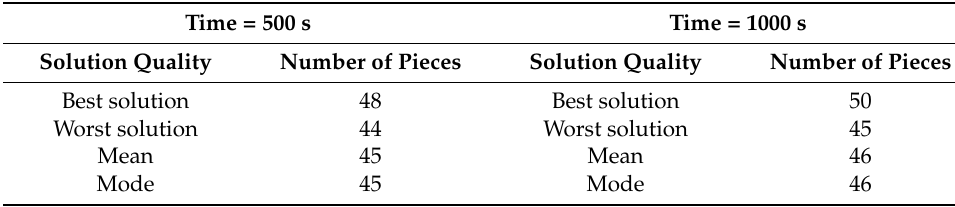
Figure 5. ILS landscape average of 120 tests (shapes, overlaps, and time). The total ILS iterations are 10,000. The best solutions obtained are within the range of 100,000 to 1,500,000 overlaps, with 1000 and 2000 s of execution time, as shown in Figure 5. The red dots identify the best solutions on the figure. It can be seen that the worst solutions were when the number of overlaps increased until approximately 2,000,000 overlaps. Peaks and valleys are observed in the figure, representing the best and worst solutions, respectively. This behavior indicates that the quality increase is not directly or inversely proportional to the ILS execution time. It is observed that bad solutions in the landscape surround the best solutions. This behavior indicates that the ILS execution can find good solutions in each of its executions. Tables 2 and 3 show a summary of all results obtained by the implemented algorithm. Table 2. ILS behavior with different executions times.